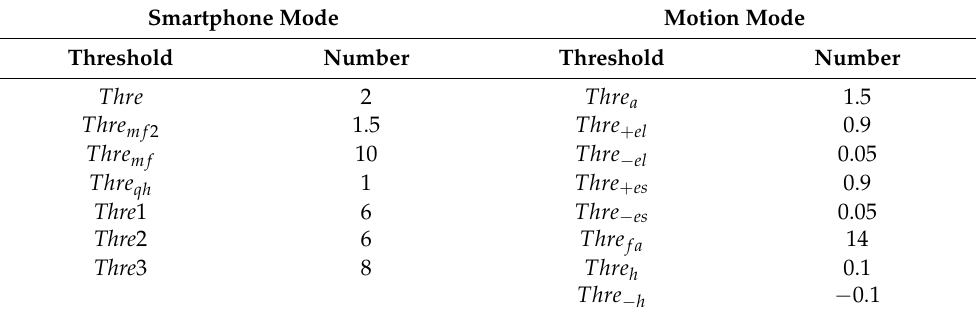
Table 8. The threshold of smartphone mode and motion